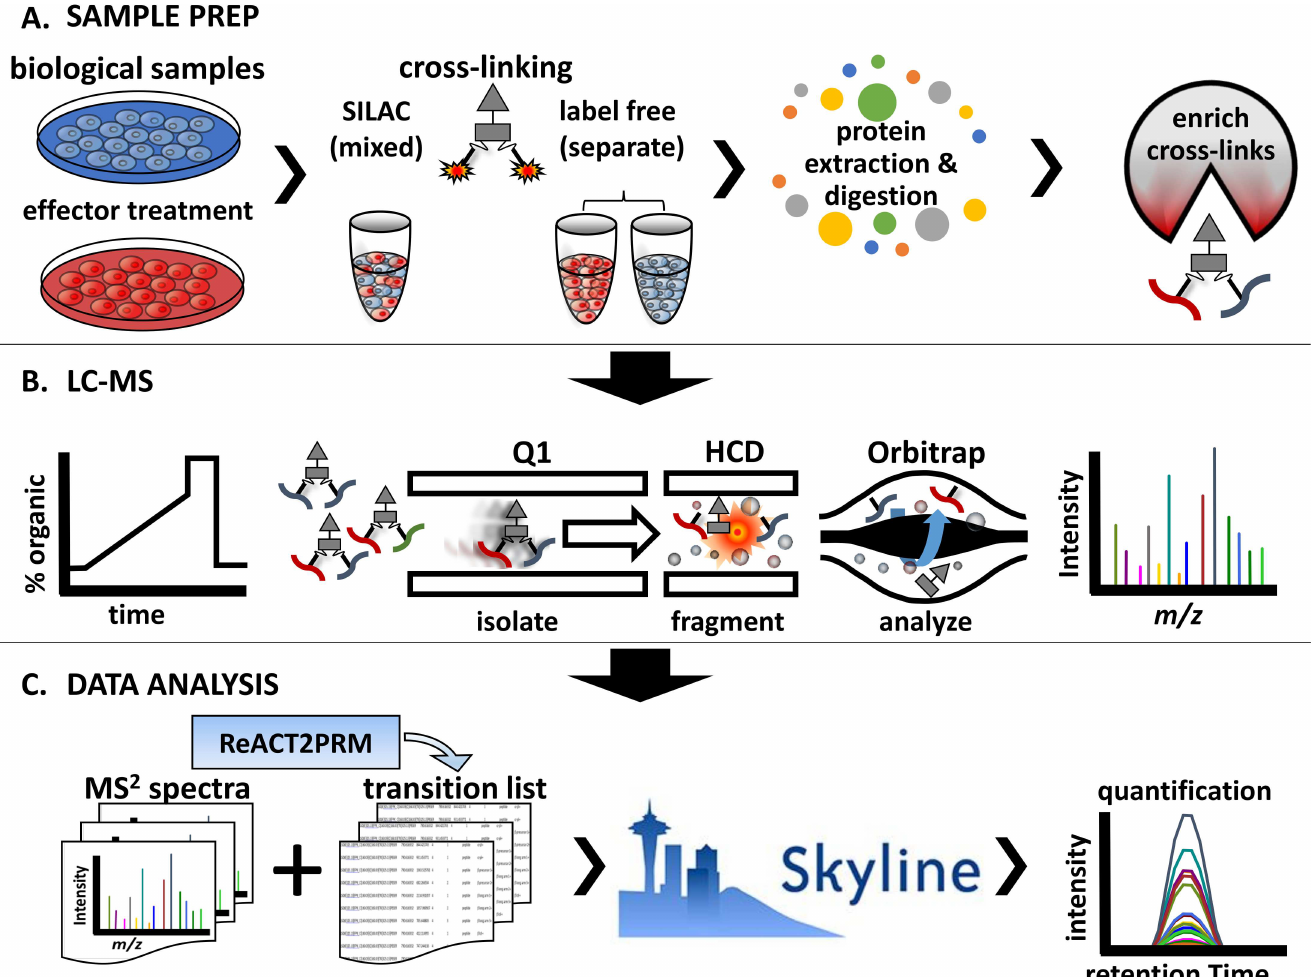
Fig 1. Experimental outline. A. Biologicalsamples are preparedfor qXL-MS comparing two or more conditions. The samples are treated with chemical cross-linkereither as (1) a mixed sample if SILAC labelingwas used or (2) as separatesamples if carrying out a label free experimentor using isotopically labeledcross-linkers. Followingthe cross-linking reactionproteins are extracted, enzymatically digested,and subjectedto variousstrategies (i.e. strong cation exchangeand affinity chromatography) for enrichment cross-linkedpeptidepairs. B. LC-MS analysisof samples enrichedfor cross-linkedpeptide pairs is carried out. This consists of reversed phasechromatographic separation by LC followedby analysisby MS. The mass spectrometer is operatedin PRM mode where an inclusionlist of m/z values for the precursor ions of interest is used to target specific cross-linked peptides. The PRM mass spectrometric analysisused here consists of three steps including isolationof precursor ions, fragmentation by collisionwith neutral gasses, and detection of mass to chargeratios of the resulting fragment ions. C) ResultingMS2 data are convertedinto transition lists and importedinto Skyline for